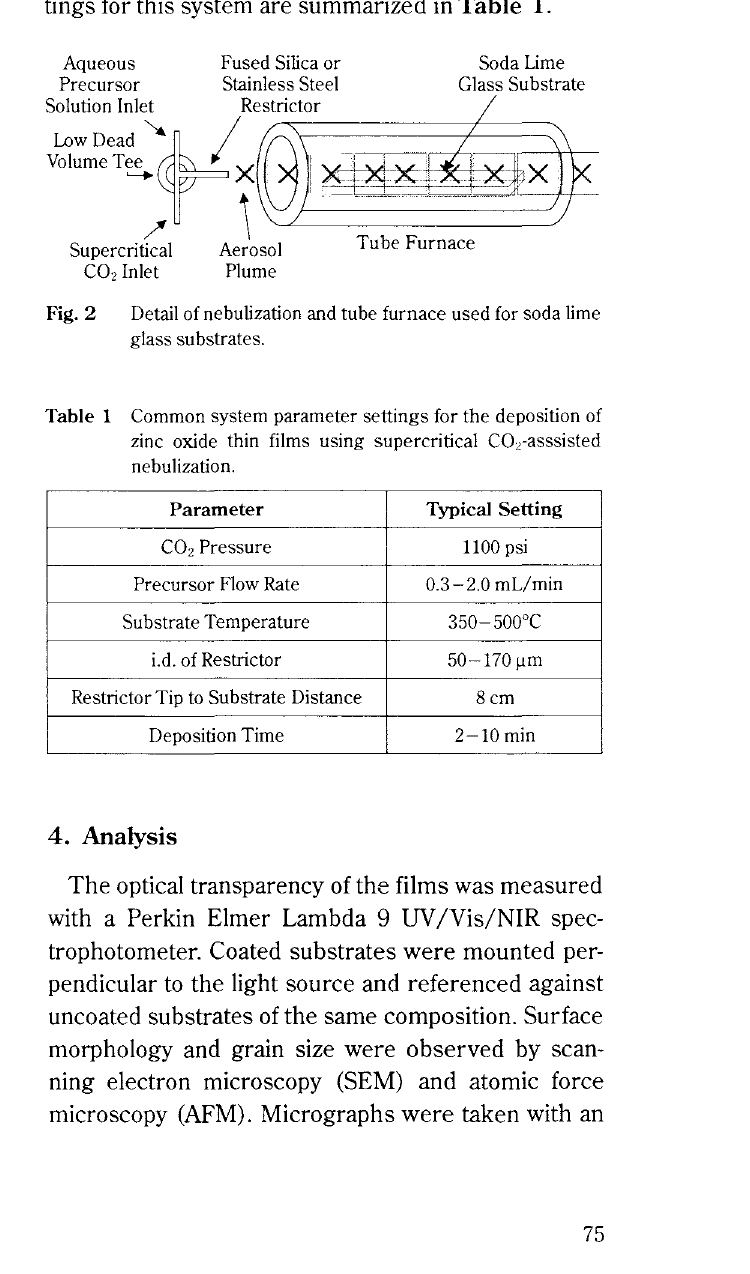
Table 1 Common system parameter settings for the deposition of zinc oxide thin films using supercritical CO,-asssisted